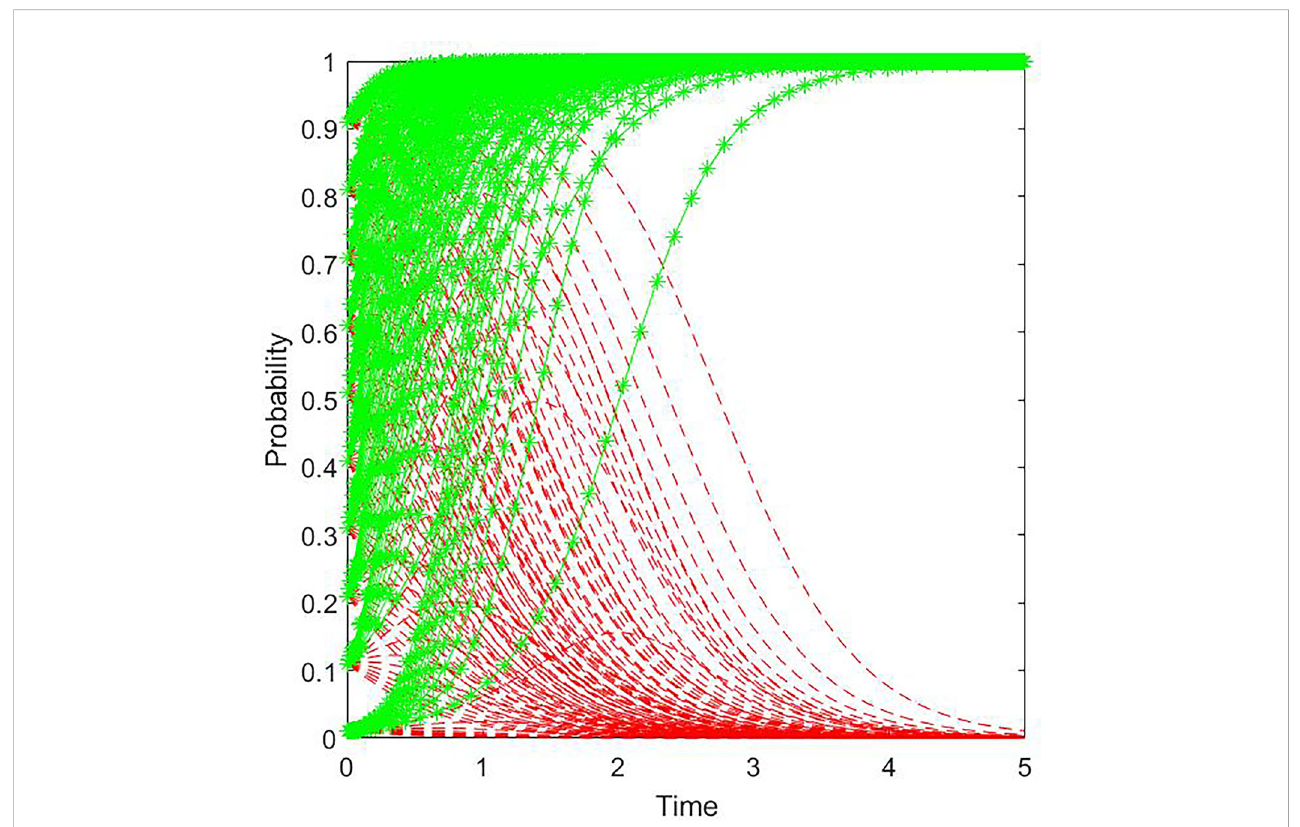
FIGURE 5 Evolutionary path diagram of the two-party game system with different initial probabilities (Scenario 2). (Note: The red curve represents the government and the green curve represents shipping